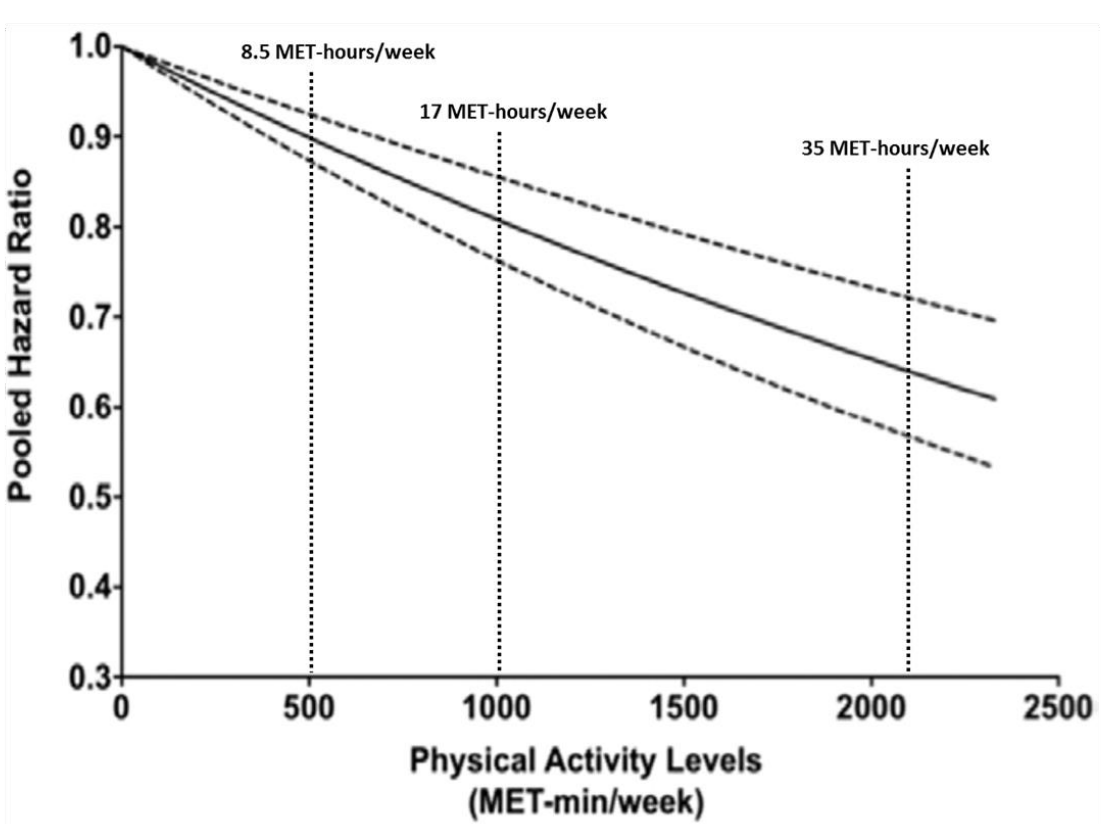
Figure F6-7. Dose-Response Relationships Between Moderate-to-Vigorous Physical Activity and Risk of Incident Heart